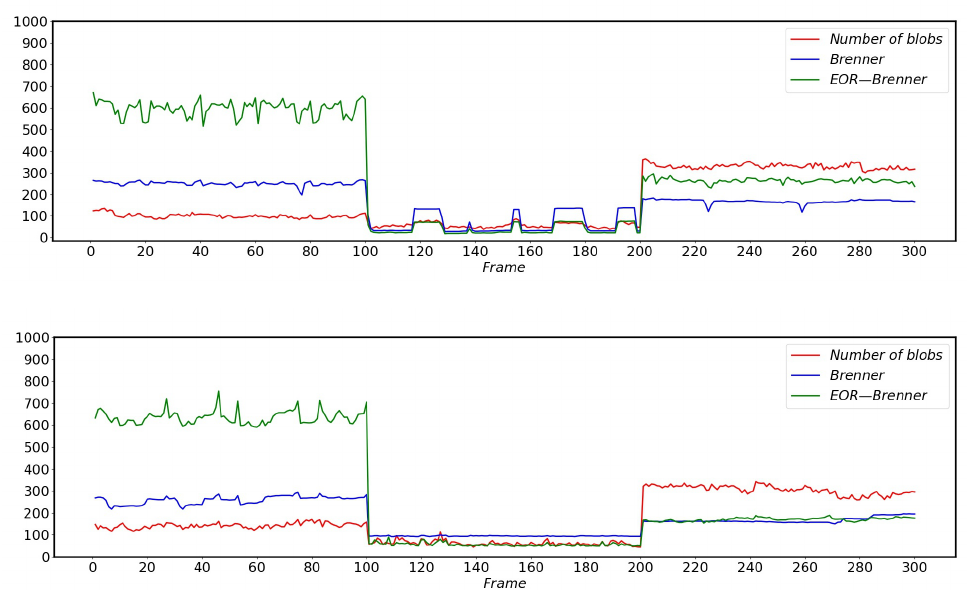
Figure 28. EOR-Brenner evaluation results of images captured by HSR-A and HSR-B under differ- ent